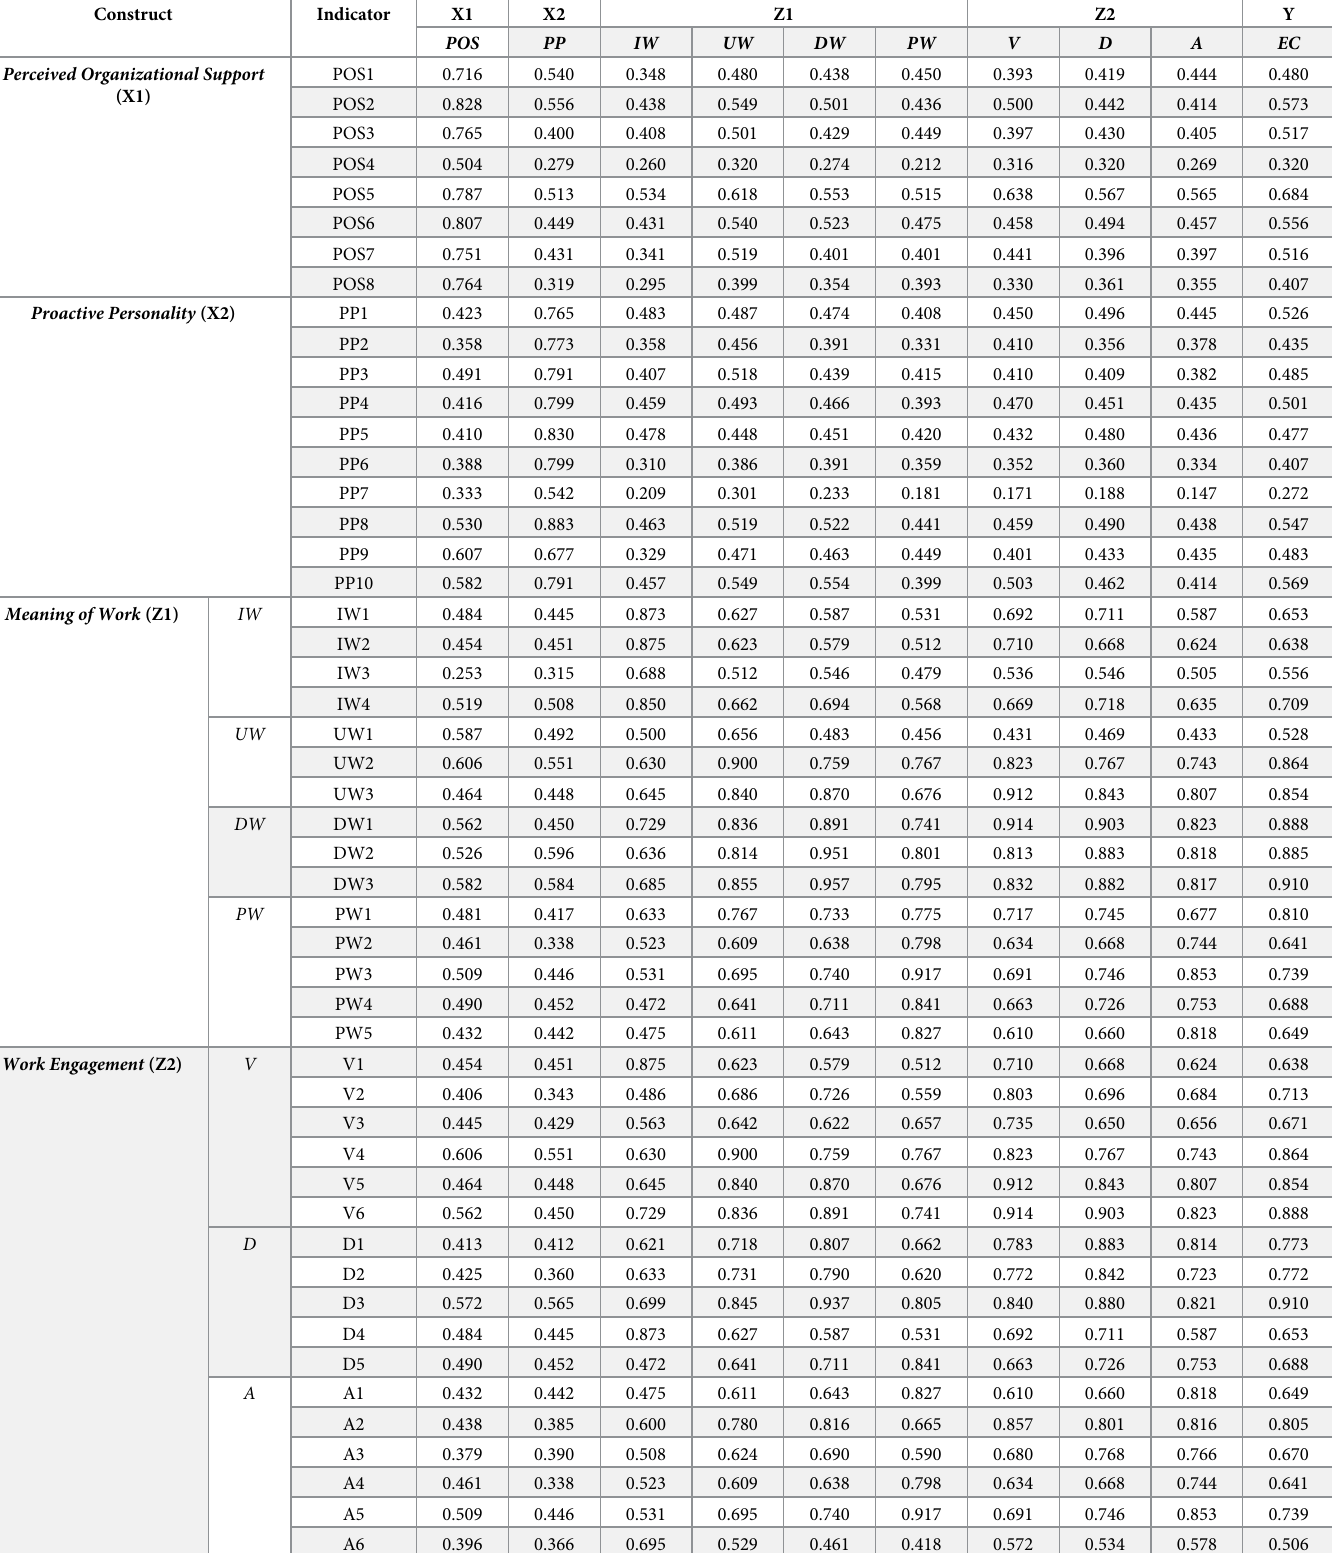
Table 3. Cross loading